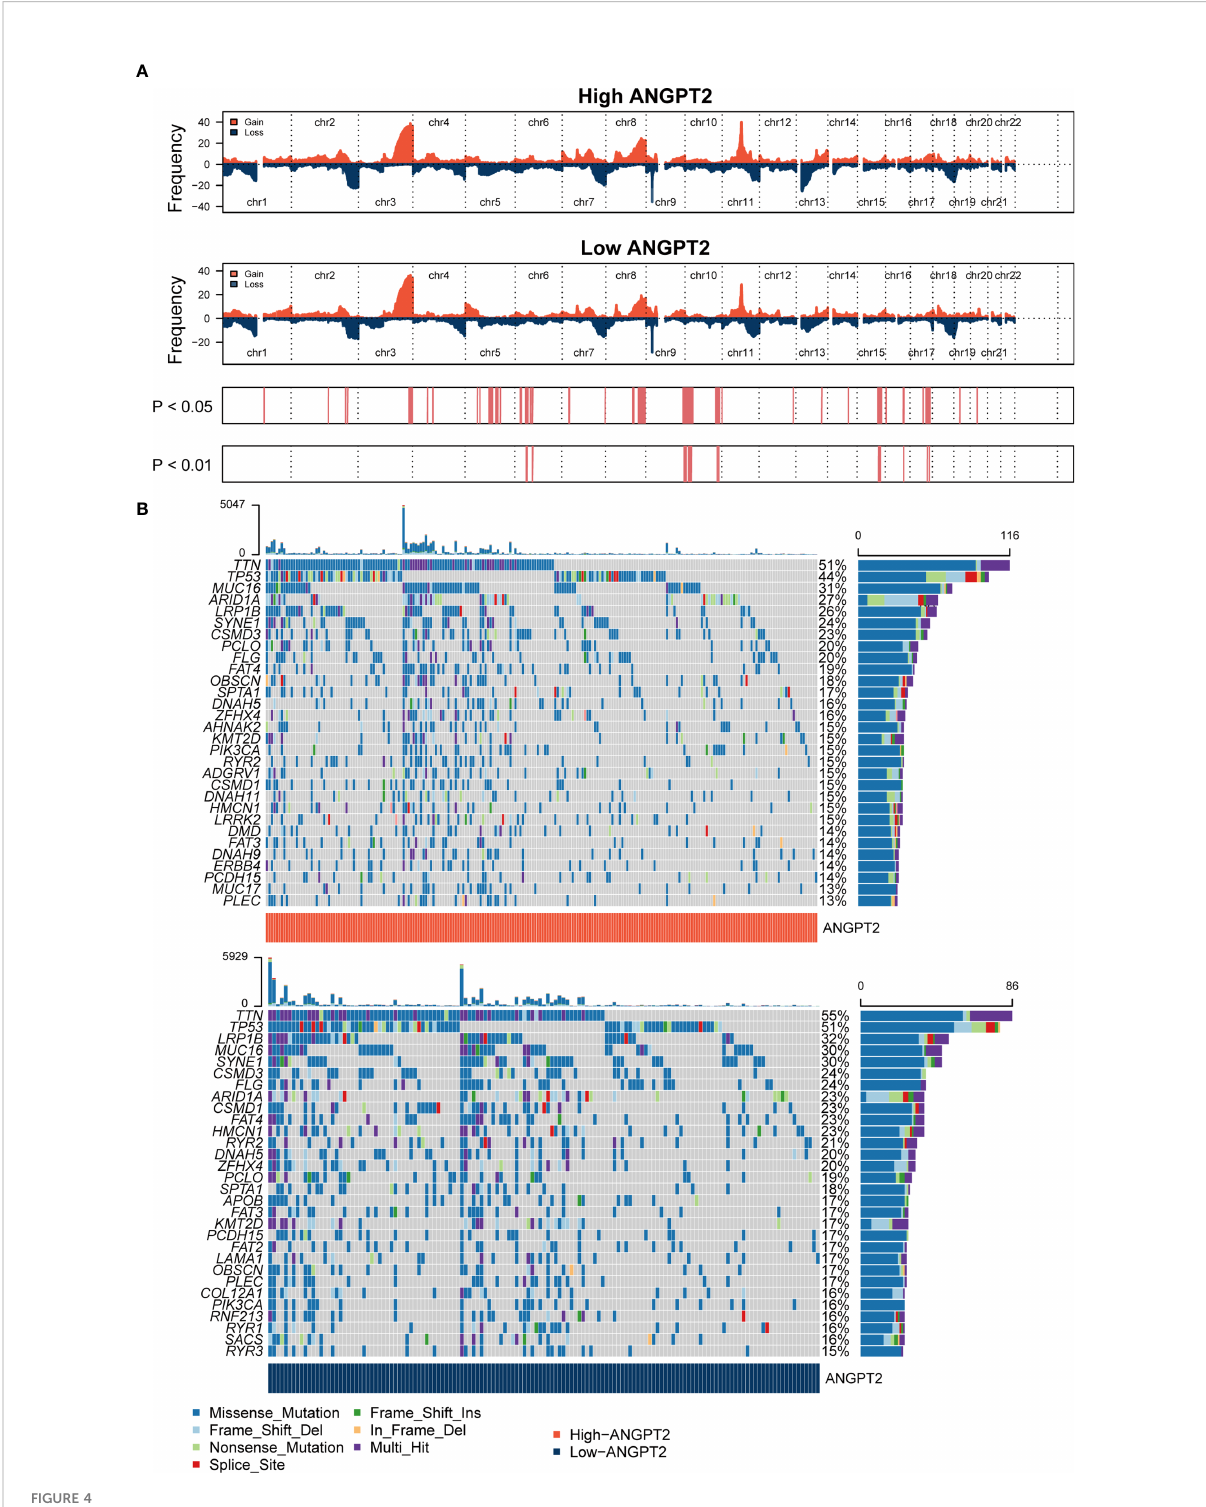
FIGURE 4 Genomic changes related to ANGPT2 in STAD samples (A) Changes in the copy number of ANGPT2 between high and low STAD groups. (B) Somatic mutation waterfall map in STAD of high and low ANGPT2